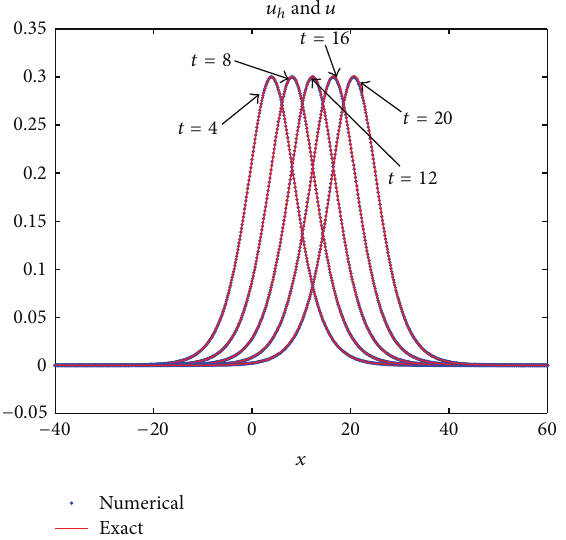
Figure 5: Comparison between 𝑢 and 𝑢 ℎ at times 𝑡 = 4 , 8 , 12 , 16 , and 20 with ℎ = 0.125 and Δ𝑡 = 0.2 .